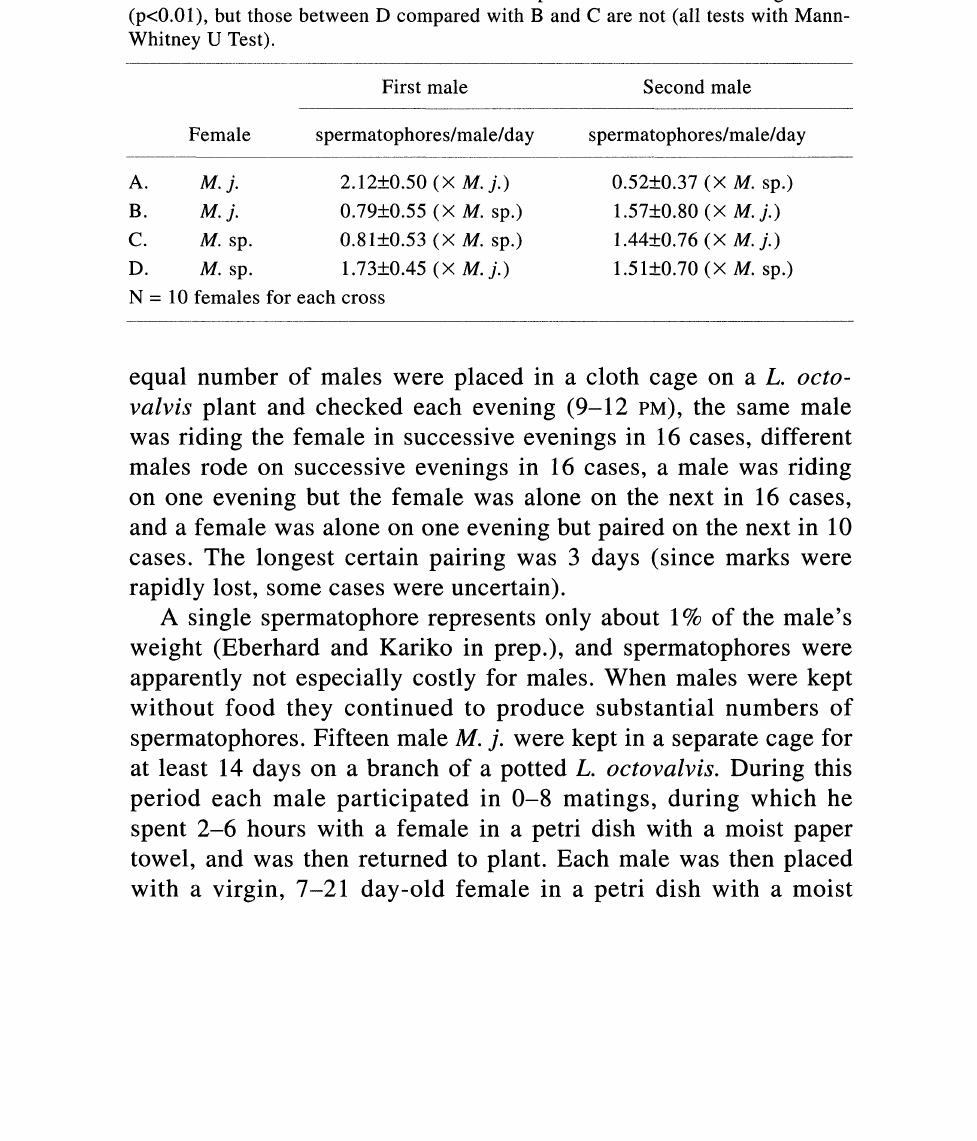
Table 5. Numbers of spermatophores found in petri dishes with different pairs of Macrohaltica beetles. Females were kept isolated from males for the first 9-10 days of their lives. Then each female was kept for 8-10 days with a given male ("first male"). After this time, the male was replaced with a male of the other species ("second male"). Crosses were the following: A female M. j. first with male M. sp. then with male M. j.; B female M. j. first with male M. j., then with male M. sp.; C female M. sp. first with male M. j., then with male M. sp.; D female M. sp. first with male M. sp., then with male M. j. All differences between first and second male are significant (p<0.05) except for D. All differences between M. j. males and M. sp. males within first male category are significant (p<0.001); the dif- ferences in second male data between A compared with B and D are significant (p<0.01), but those between D compared with B and C are not (all tests with Mann- Whitney U